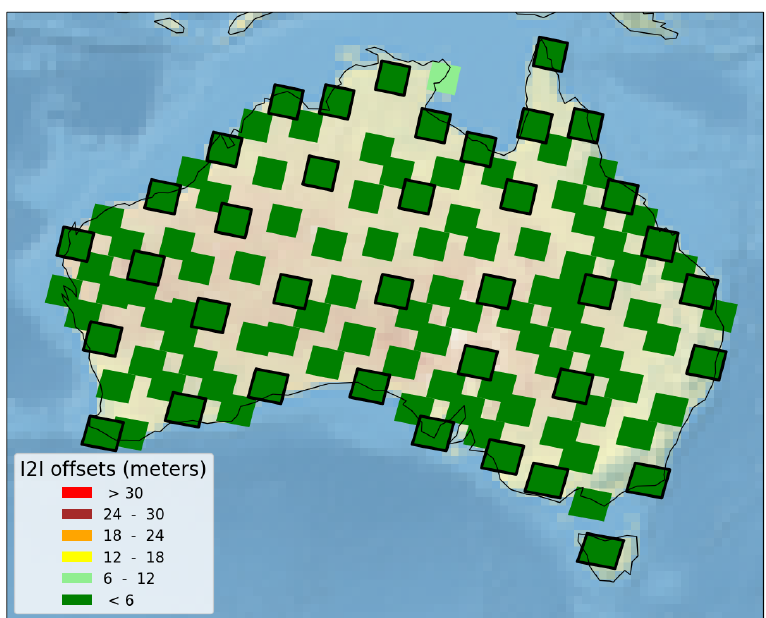
Figure 7. Residual offsets between Landsat 8 orthorectified products using GLS GCPs after AGRI-constrained triangulation adjustment and the AGRI reference data using the image-to-image (I2I) characterization procedure. The anchor sites are indicated by black outline. Note that using the AGRI-constrained solution, almost all of the test sites are within 6 m with respect to the AGRI